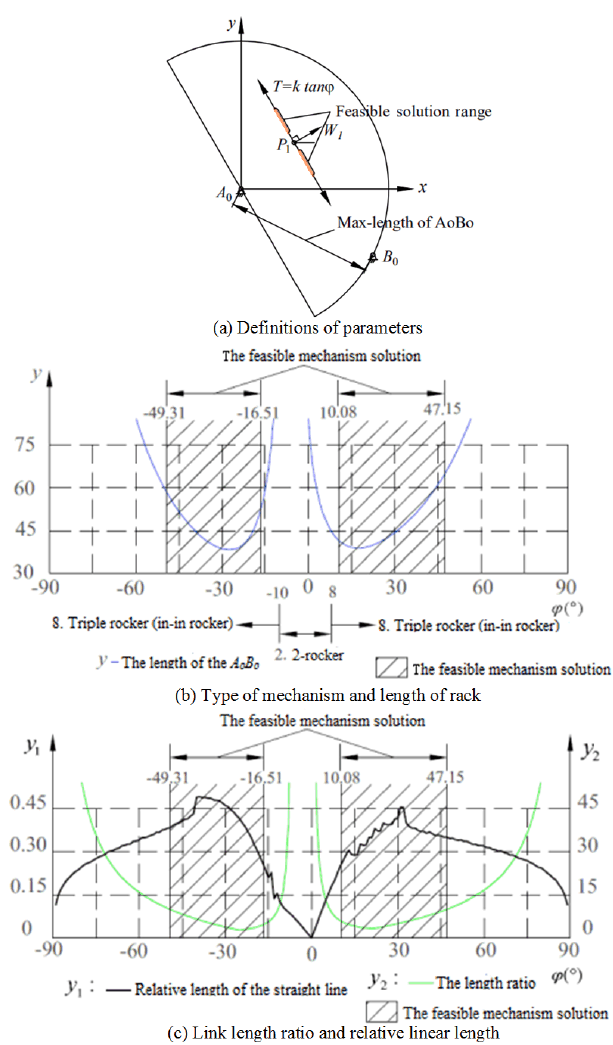
Figure 6. Mechanism solutions with different displacements T